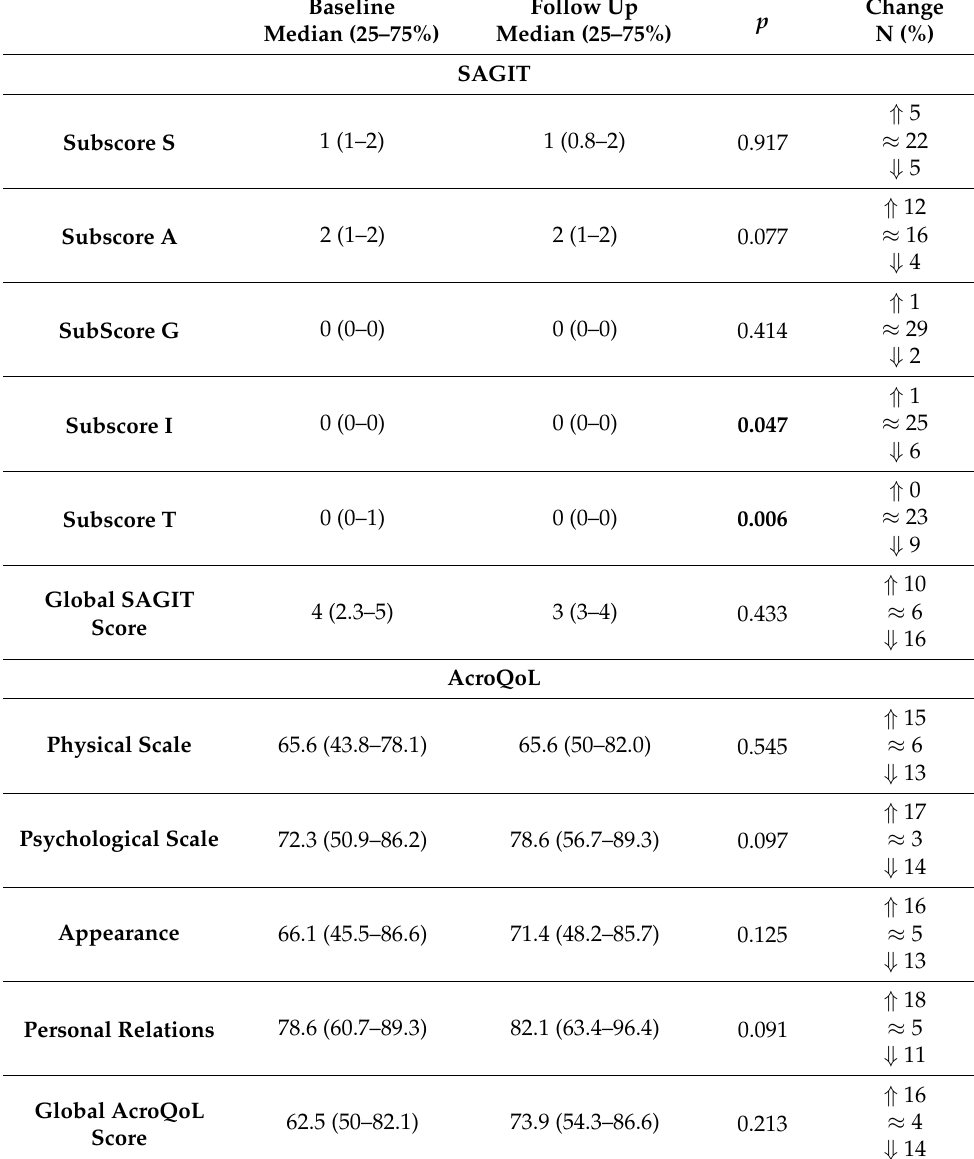
Table 2. The comparison of SAGIT scores and AcroQoL results between both